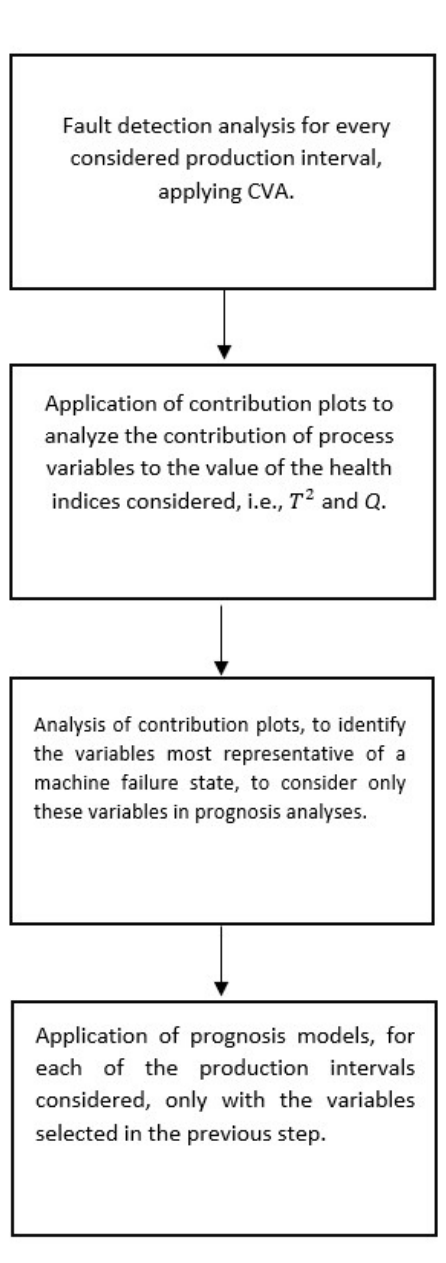
Figure 1. Methodology for the proposed model.